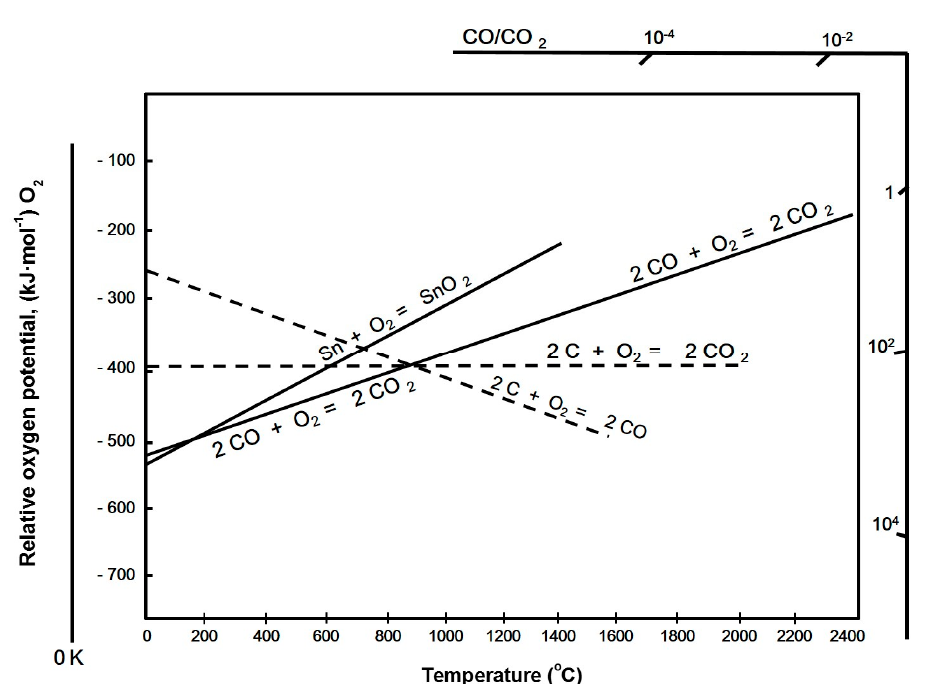
Figure 9 . Ellingham diagram for tin oxide reduction. Figure 9. Ellingham diagram for tin oxide